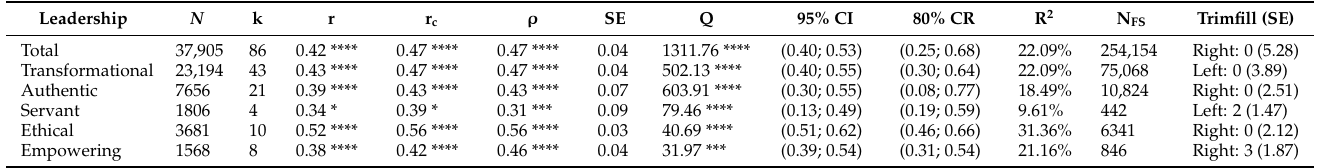
Table 2. Results